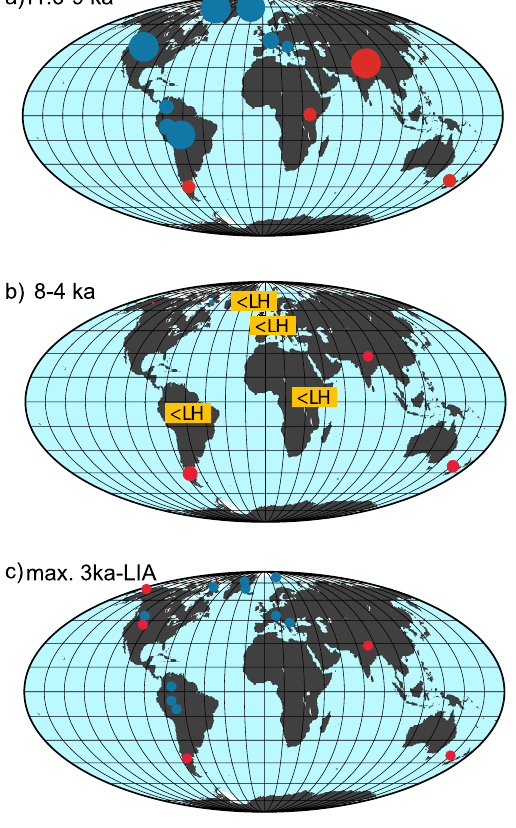
Fig. 1 Alpine glacier length variations during the Holocene based on new CRE glacier chronologies and those indexed in the ICE-D alpine database. Mean normalized regional glacier length in different regions and for different time periods, between ( a ) 11.6-9 ka, b 8-4 ka, c 3 ka-LIA ( “ Methods ” and Supplementary Data 1 and 2). Glacier lengths dated with 10 Be are represented by circles. The sizes of the circles indicate the paleo- ice extent normalized to the LIA extent. Therefore all circles indicate 1 for the LIA and larger circles for other periods indicates a glacial extent larger than during the LIA (1 = LIA extent, 2 = 2 times larger than the LIA). Each symbol corresponds to a mean regional value ( “ Methods ” , Supplementary Data 2, n = 66). “ <LH ” refers to “ smaller than the late Holocene ” and indicates sites where in situ 14 C and 10 Be from deglaciated bedrock samples or other chronological constraints demonstrate that glaciers were smaller during the documented period than during the late Holocene (Greenland after ref. 12 ; Alps after ref. 27 ; East Africa after ref. 68 , Bolivia, this study). TANAR pattern (blue circles) refers to a larger extent during the early Holocene than during the late Holocene with substantial shrinking during the